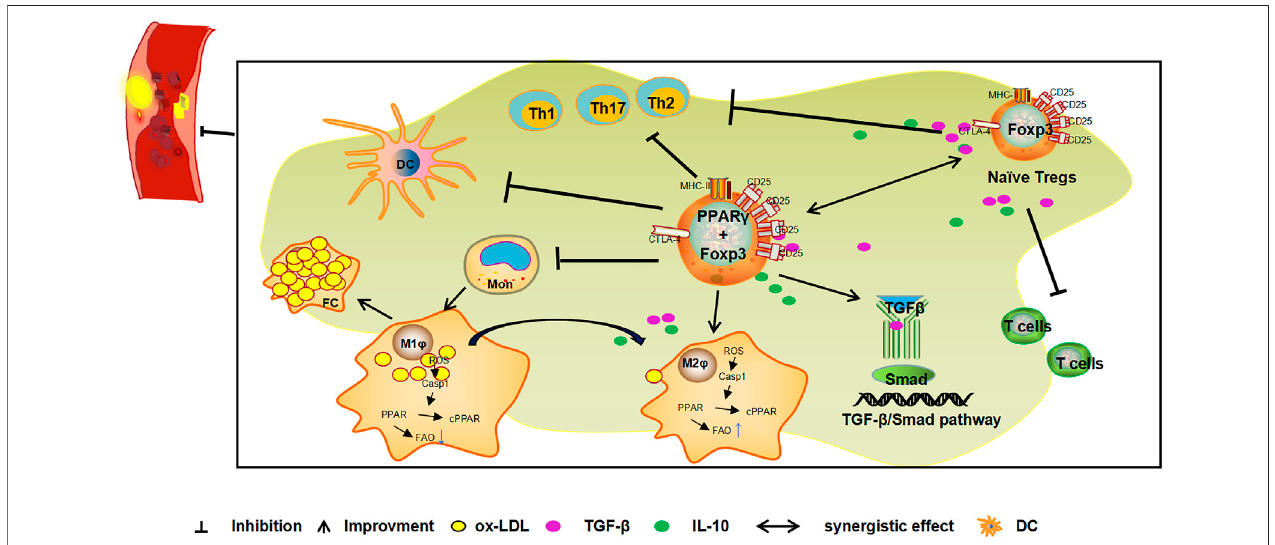
FIGURE 3 | Mechanism of the combined action of PPAR γ and Tregs against AS. Tregs expressing PPAR γ in VAT exert inhibitory effects on immune cells activity and prevents the occurrence and development of in fl ammation. Foxp3 is a speci fi c molecule of Tregs. The ectopical co-expression of Foxp3 and PPAR γ can induce an increase in Treg levels and the release of cytokines such as TGF- β and IL-10 to inhibit in fl ammation and exert anti-AS effects. In addition, PPAR γ indirectly induces the expression of Tregs by promoting the transformation of macrophages to the anti-in fl ammatory M2 type and induces the secretion of cytokines such as TGF- β and IL-10 by M2 type macrophages. PPAR γ also inhibits the in fl ammatory response and plays a role in the anti-AS by activating the TGF- β /Smad signalling pathway and inhibiting the Th1, Th2, Th17/Tregs ratio.